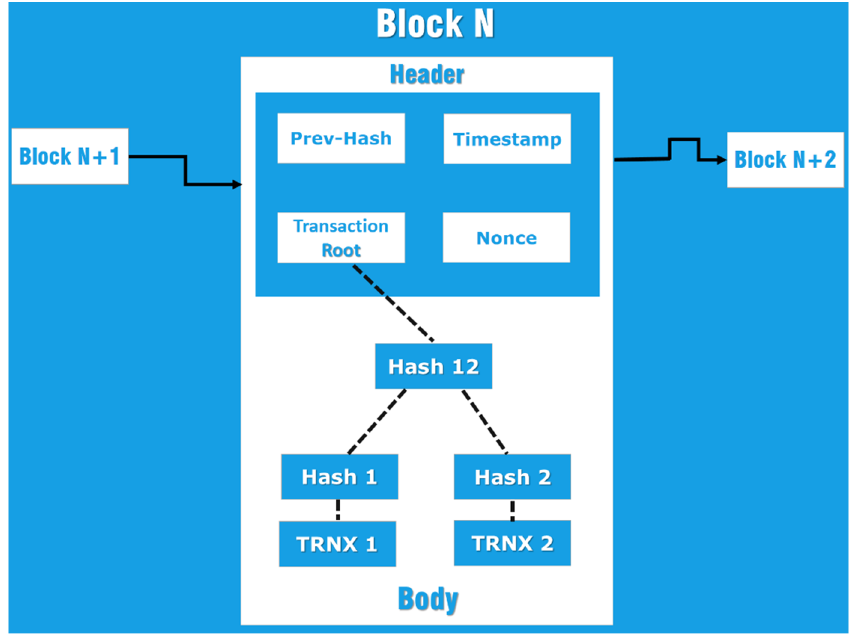
Figure 1. Block Structure